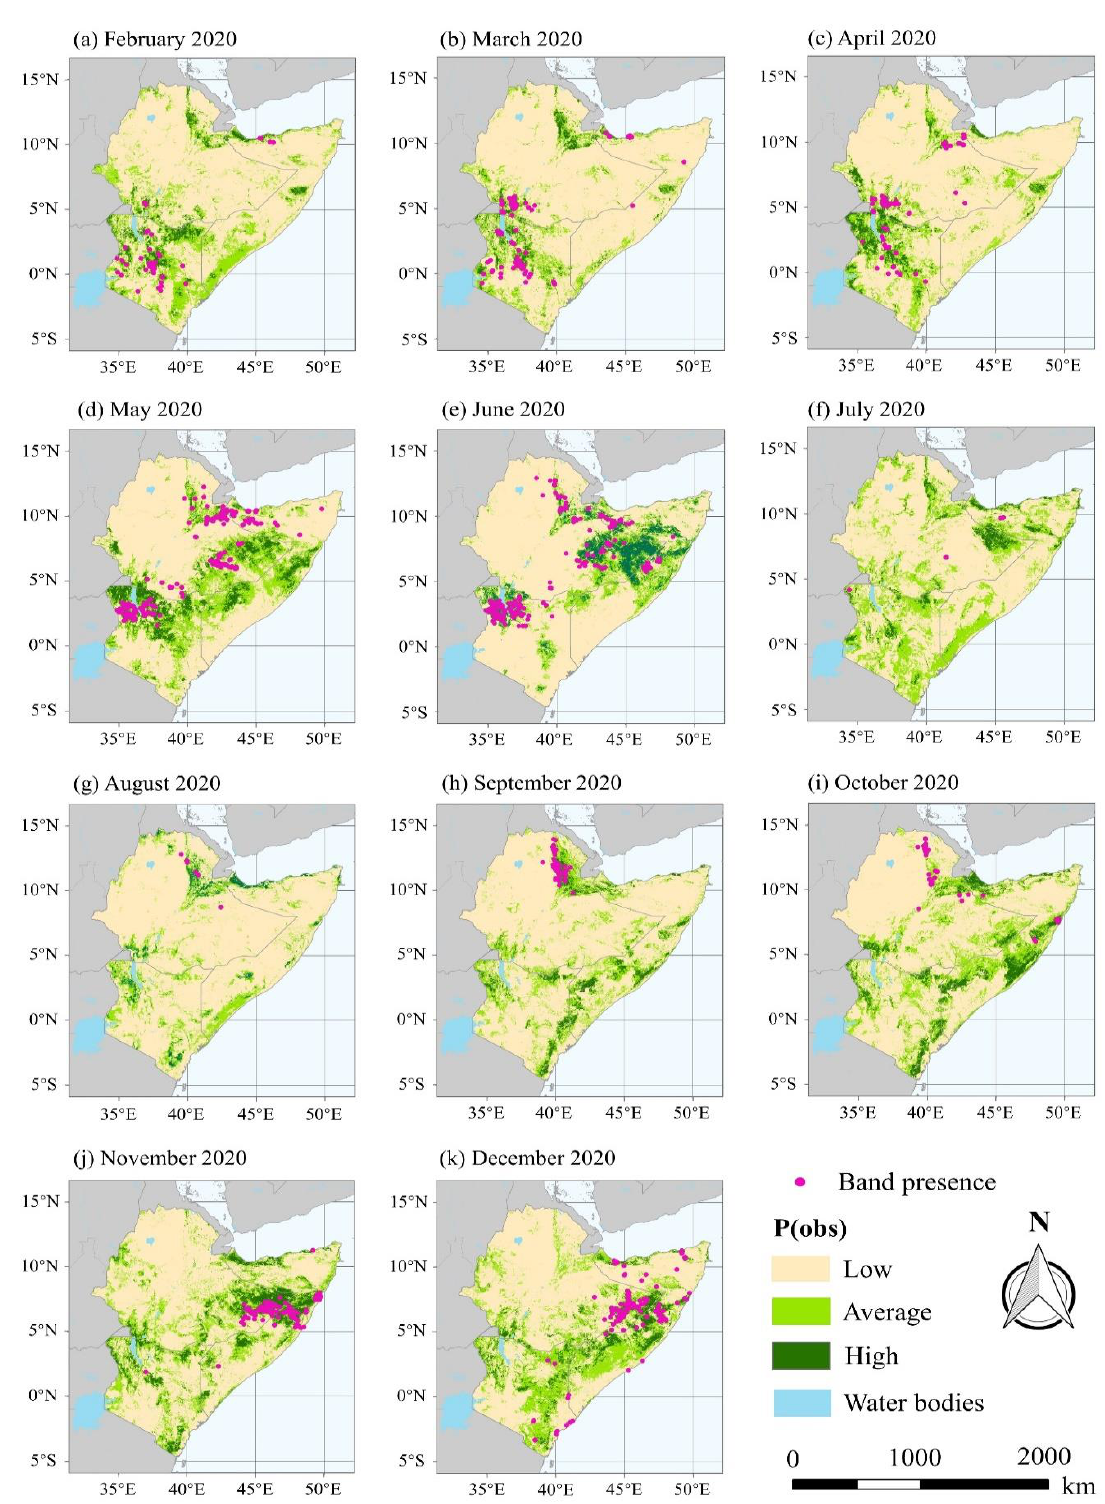
Figure 8. Dynamic projected areas with classified probabilities of band presence and monthly ground truths of band presence in SEK from February 2020 to December 2020. Areas were divided into low and average probability of band presence by statistics at max TPR + TNR of training models as dichotomous thresholds for model evaluation, while the high probability area partitioned by the first quartile was only used for better visualization and demonstration. ( a ) February 2020, ( b )